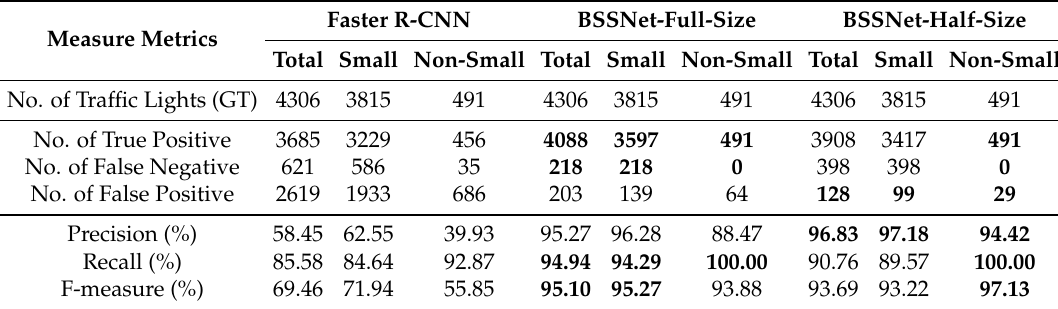
Table 2. TL candidate detection